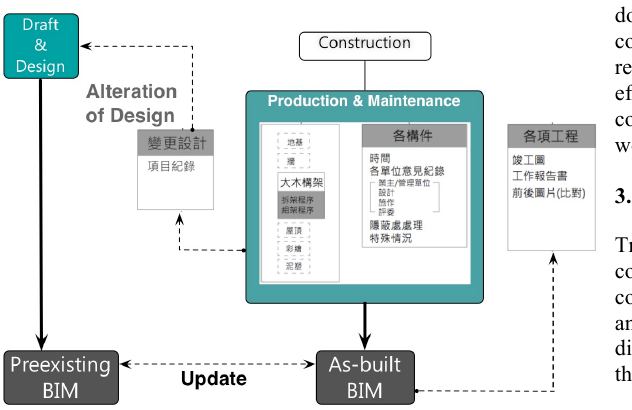
Figure 6. BIM modeling process in repair construction